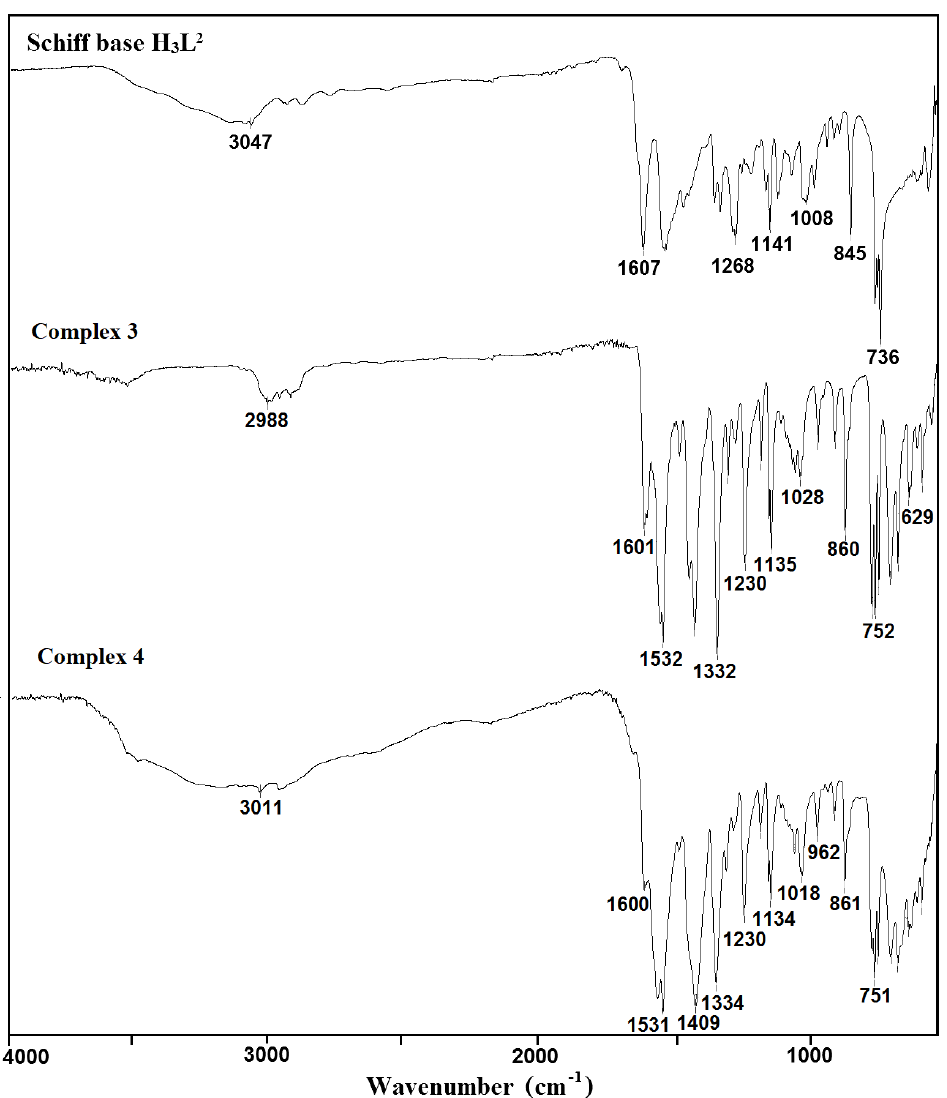
Figure 2. FTIR spectra of the Schiff base ligand H 3 L 2 and complexes 3 and 4.